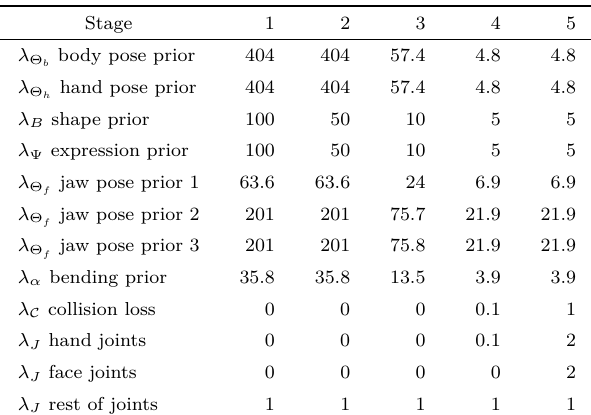
Table 1 Weights λ used by SMPLify-X and subsequent phases for the different priors and terms in Eq.